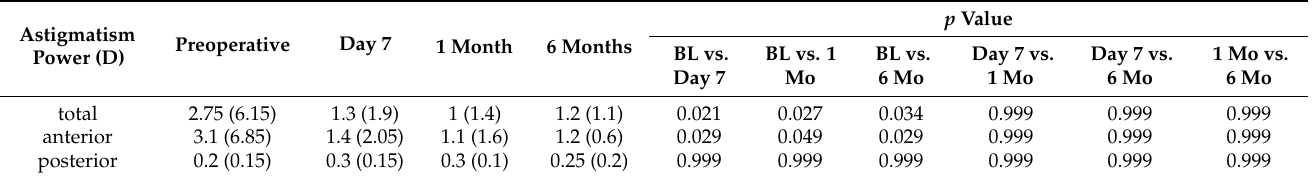
Table 3. Analysis of astigmatism power in eyes with pterygium removal by autologous conjunctival autograft with human fibrin tissue glue.